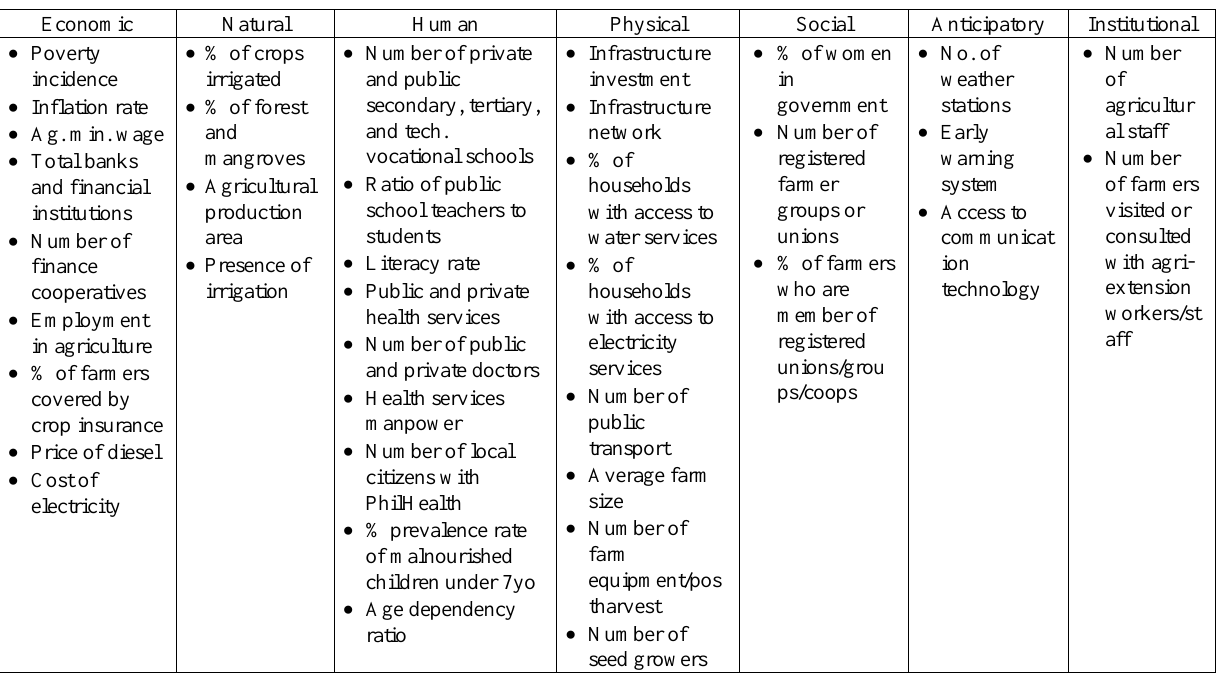
Table 5. List of indicators used in measuring adaptive